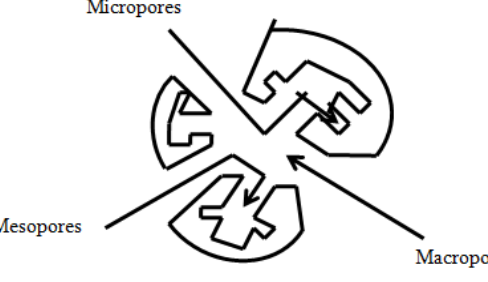
Figure 5. Positions of micro, meso, and macropores on a catalyst active site.